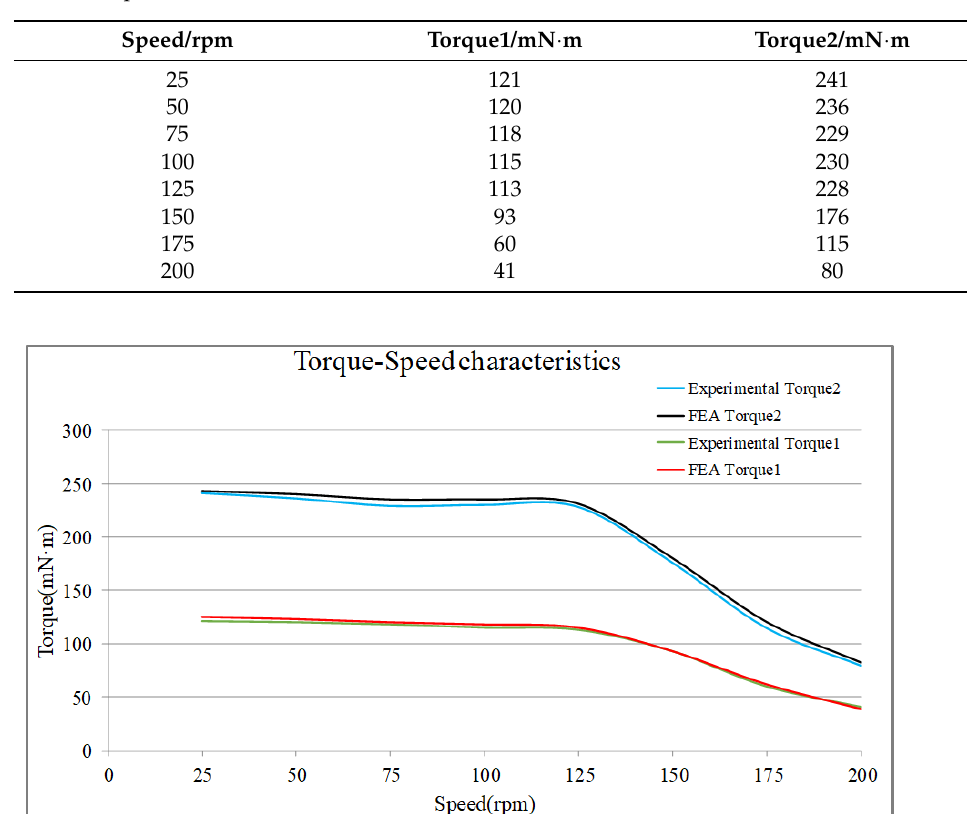
Figure 11. The experimental results and the simulation results.